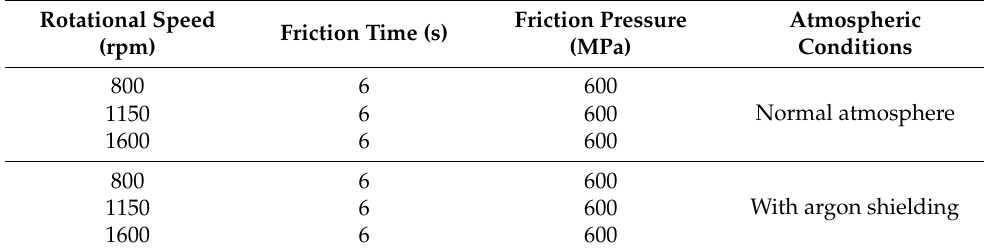
Table 7. Plan of Table 7. Plan of experiments.